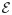
Illustration of the short-term thermodynamic balance between primary energy consumption E and dissipation at rate G/τd (Eq 1) in a civilization experiencing long-term, proportionate material n˘ and specific potential μ growth (Eq 14).